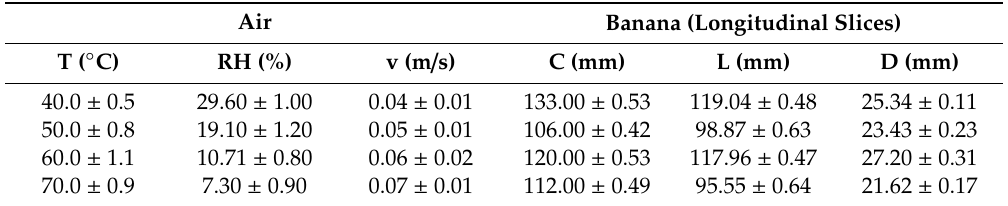
Figure 1. ( a ) Banana sliced lengthwise positioned over a small thin wire mesh (left side) and large thin wire mesh (right side) and ( b ) identification of the point for thermal measurement and geometrical parameters of the fruit. Table 1. Experimental geometrical parameters of the banana (longitudinal slices) and drying-air conditions used in this work.